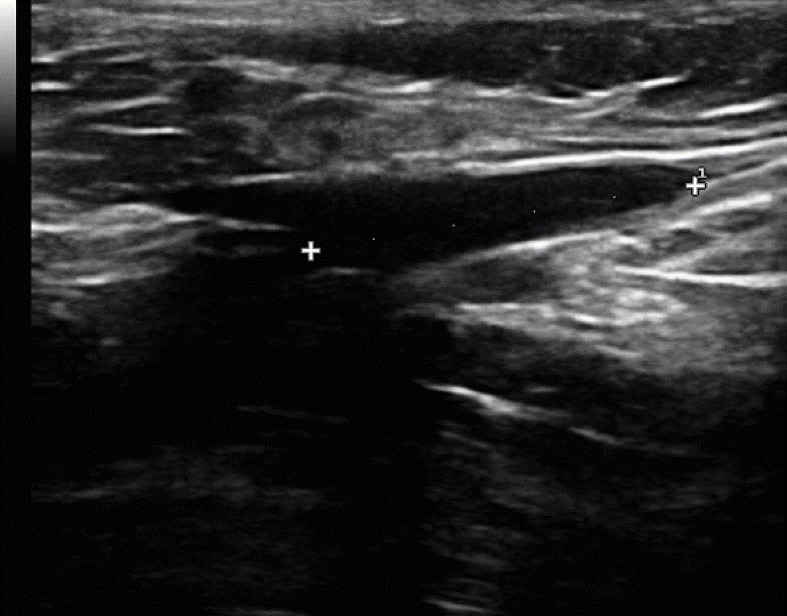
Fiber tip positioned 2 cm from the saphenopopliteal junction.